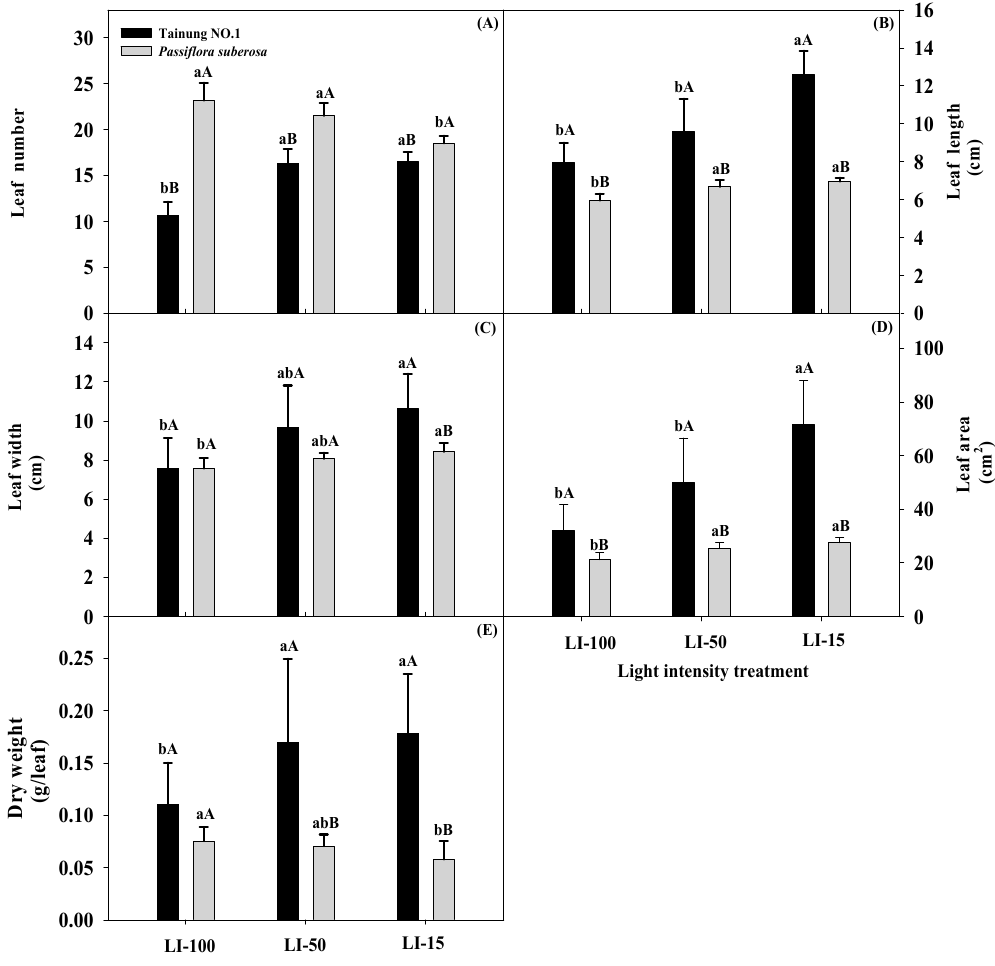
Figure 1. Effects of light intensity on the leaf number ( A ), length ( B ), width ( C ), area ( D ), and dry weight ( E ) of Tainung No. 1 and Passiflora suberosa plants. Data were recorded and calculated after 2 months of light-intensity treatment of six replicates. Means within a light treatment followed by different lowercase letters significantly differ at p ≤ 0.05 by the least significant difference (LSD) test. Means within the same light treatment of the two species followed by different capital letters significantly differ at p ≤ 0.05 by the LSD test. Each treatment was assumed to be dependent on the other. LI-100 (100% light intensity, non-shaded, as the control), LI-50 (50% light intensity, 50% shaded), and LI-15 (15% light intensity, 85% shaded) represent the average light intensity passing through in each treatment at 1396, 619, and 187 μ mol m − 2 s − 1 photosynthetic photon flux density (PPFD), respectively.